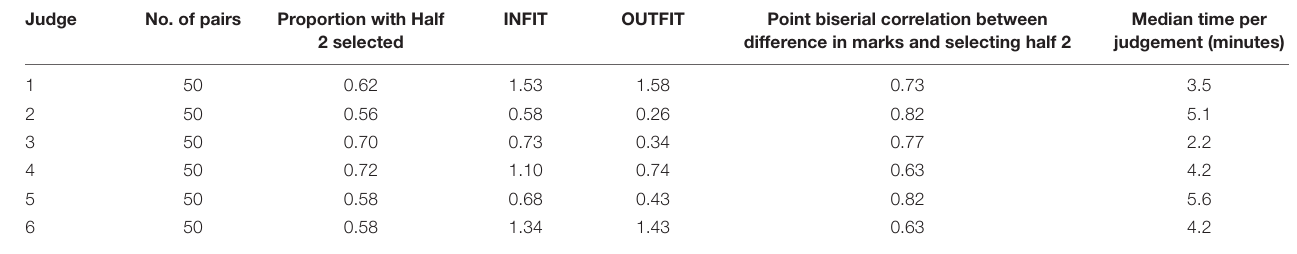
TABLE 5 | Judge fit and speed for each of the six judges (mathematics). Judge No. of